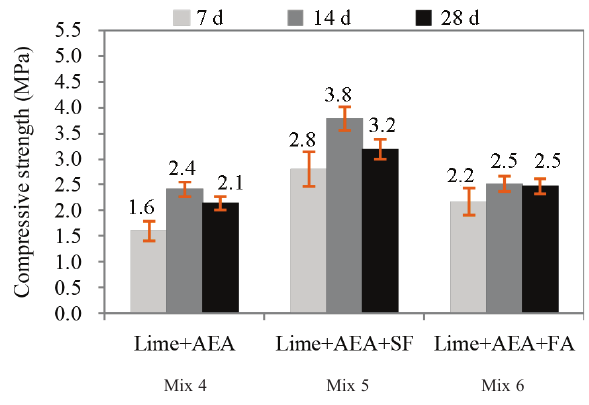
Fig. 4(c). Effect of pozzolans and AEA on the compressive strength of